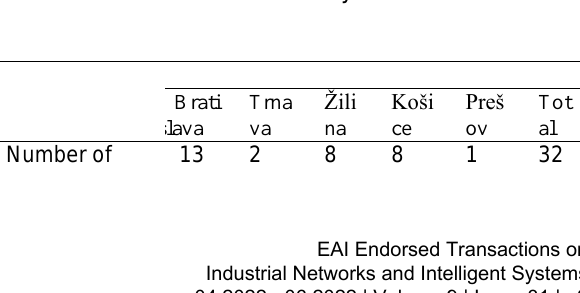
Table 1. Basic network parameters ( Source: Calculations in Gephi based on the data from a